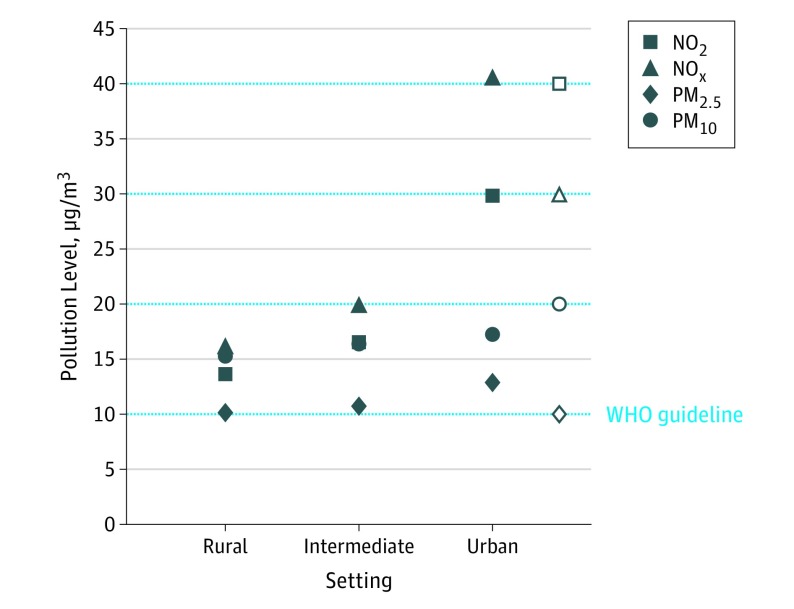
Air Pollution Levels in Rural, Intermediate, and Urban SettingsAnnualized mean exposure levels of nitrogen dioxide (NO2), nitrogen oxides (NOx), and particulate matter with aerodynamic diameters of less than 2.5 μm (PM2.5) and less than 10 μm (PM10) according to level of urbanicity. Clear markers highlight the different World Health Organization (WHO) guidelines for these pollutants.